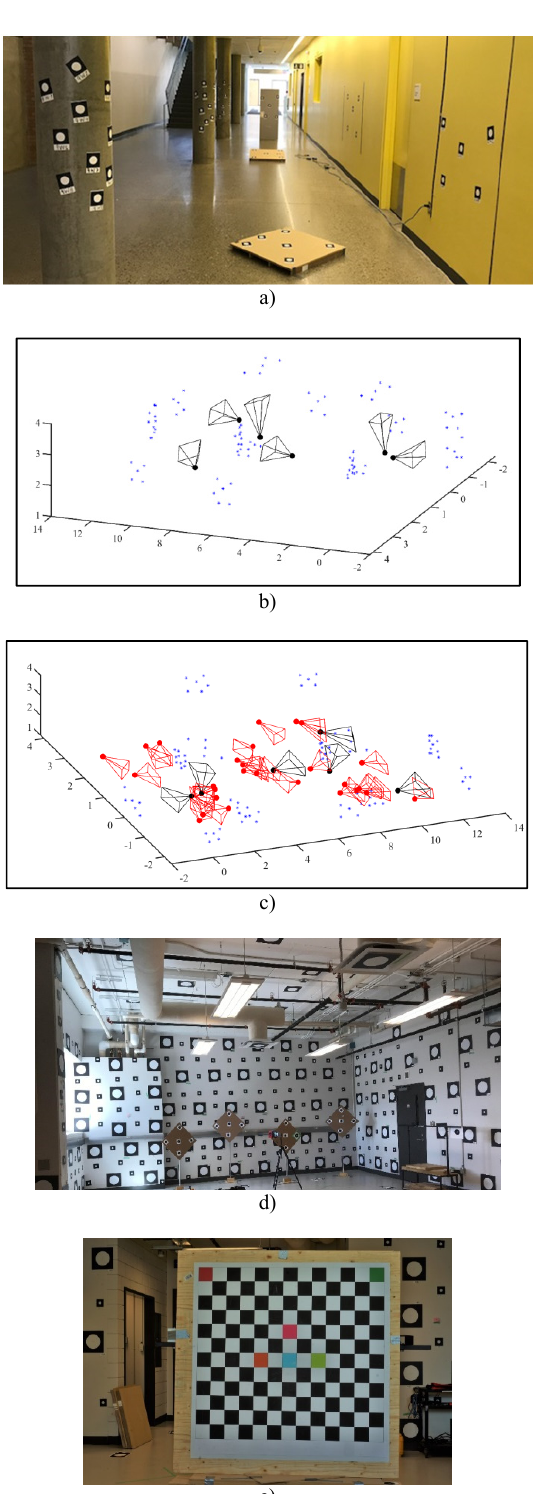
Figure 4. Workflow of lidar point cloud geo-referencing using